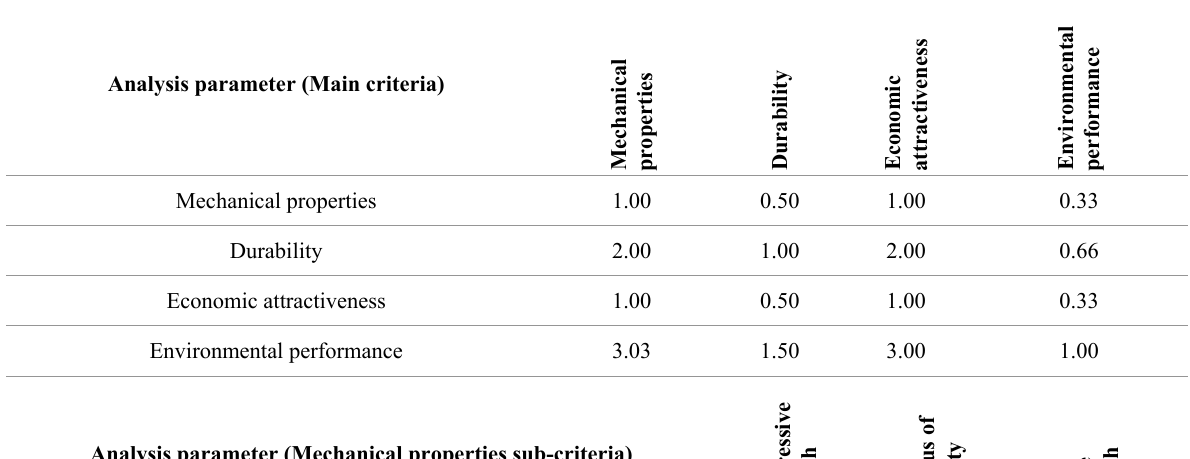
Analysis parameter (Main